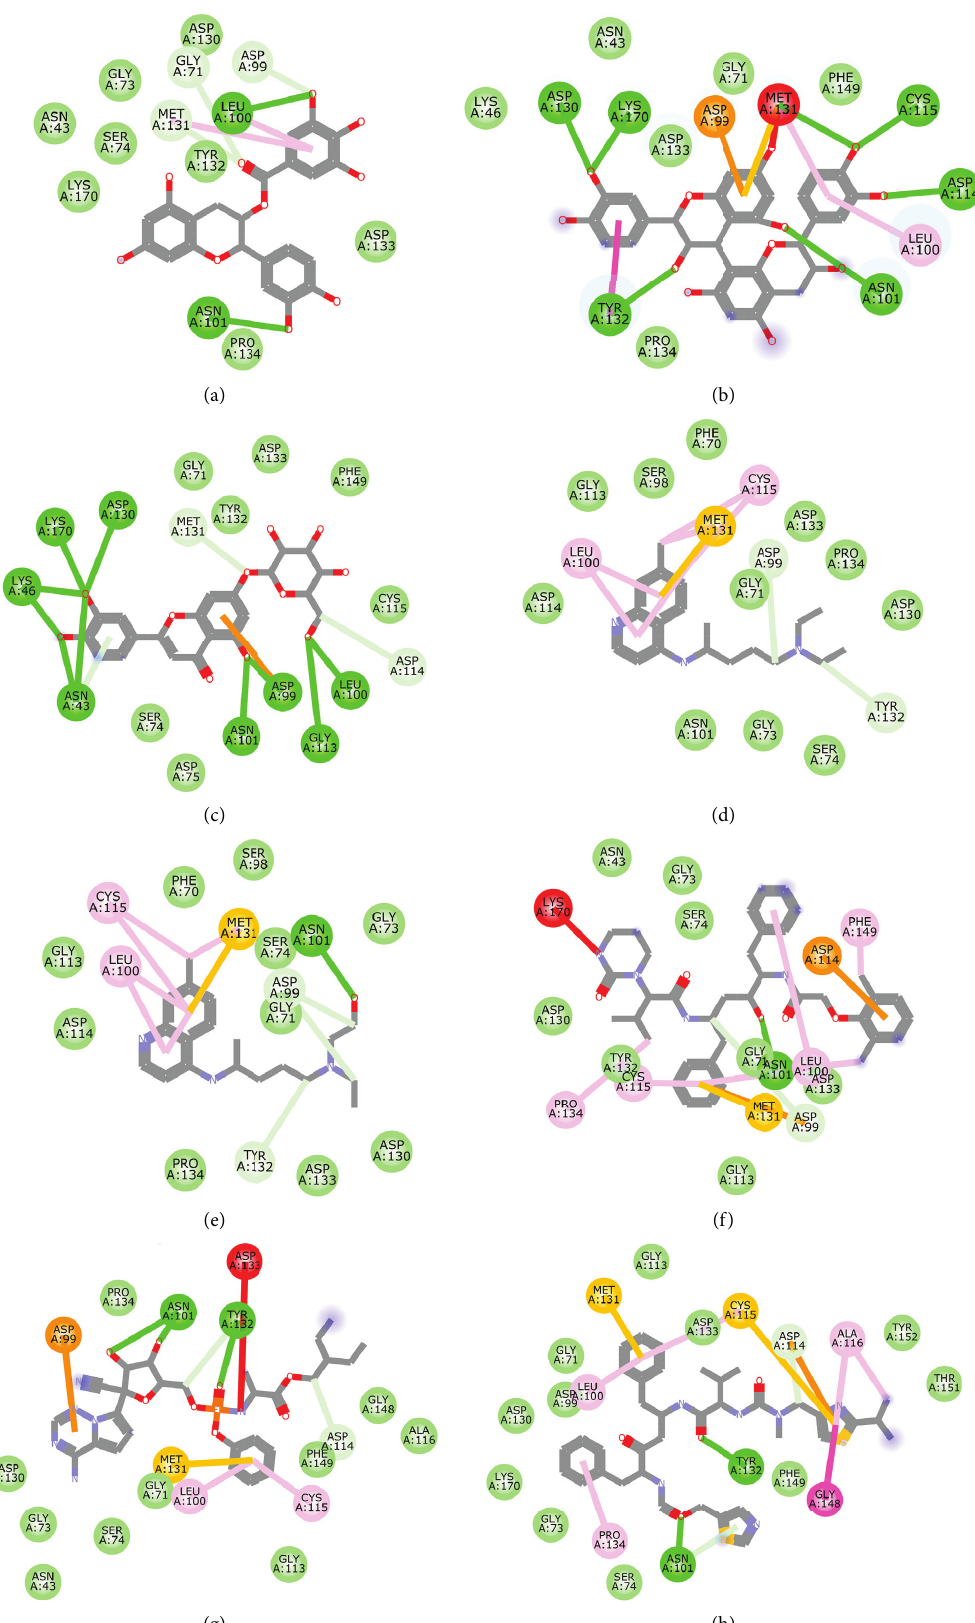
Figure 9: 2D representation of (a) 3-galloylcatechin, (b) proanthocyanidin B1, (c) luteolin 7-galactoside, (d) chloroquine, (e) hydrox- ychloroquine, (f) lopinavir, (g) remdesivir, and (h) ritonavir in the binding pocket of 2OMT. Hydrogen, carbon-hydrogen, unfavourable, and π bonds are depicted as green, light blue, red, and any other coloured (purple, magenta, orange, turquoise blue, pink, and yellow) lines, while Van der Waal interactions appear as light green